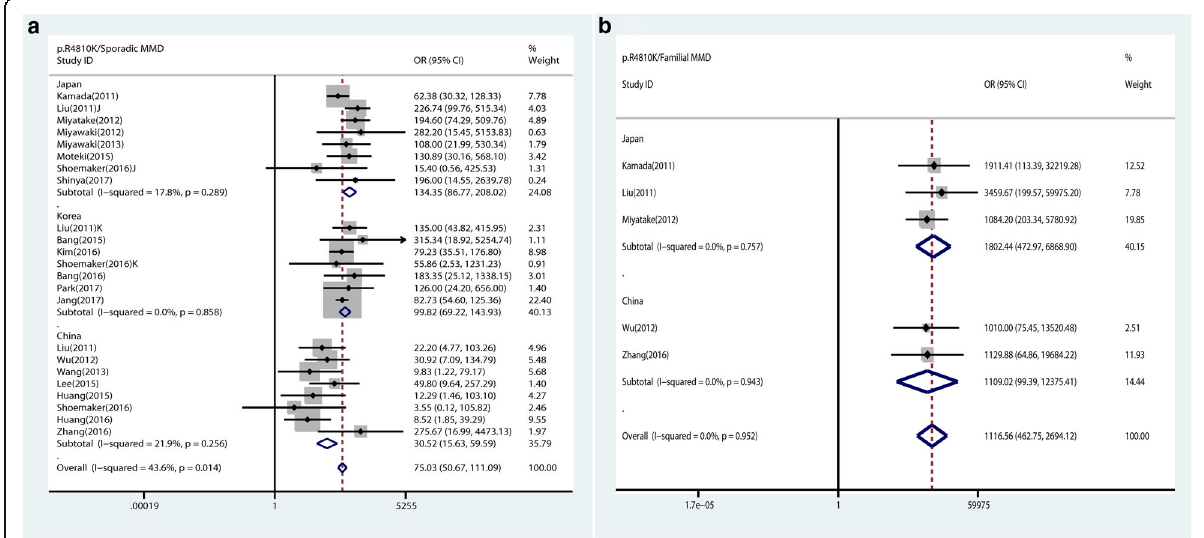
Fig. 2 Forest plots for the association of RNF213 p.R4810K with MMD under the dominant model. a Forest plots of RNF213 p.R4810K and sporadic MMD in different subgroup populations under the dominant model. b Forest plots of RNF213 p.R4810K and familial MMD in different